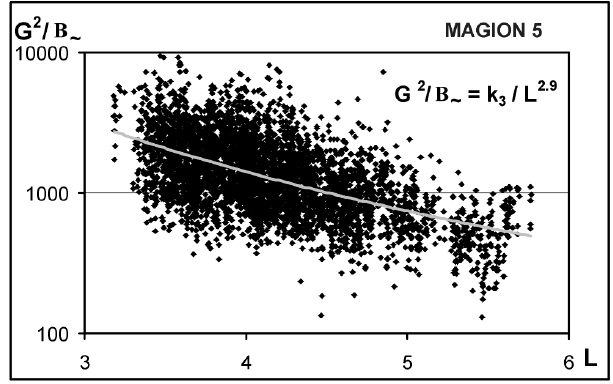
Fig. 7. The value of G 2 /B ∼ depending on L-shell for 7 orbits of MAGION 5. B ∼ is the whistler-wave magnetic field amplitude. Note that G 2 /B ∼ (L) indeed decreases as L − 2 . 9 (grey line) in good agreement with BWO